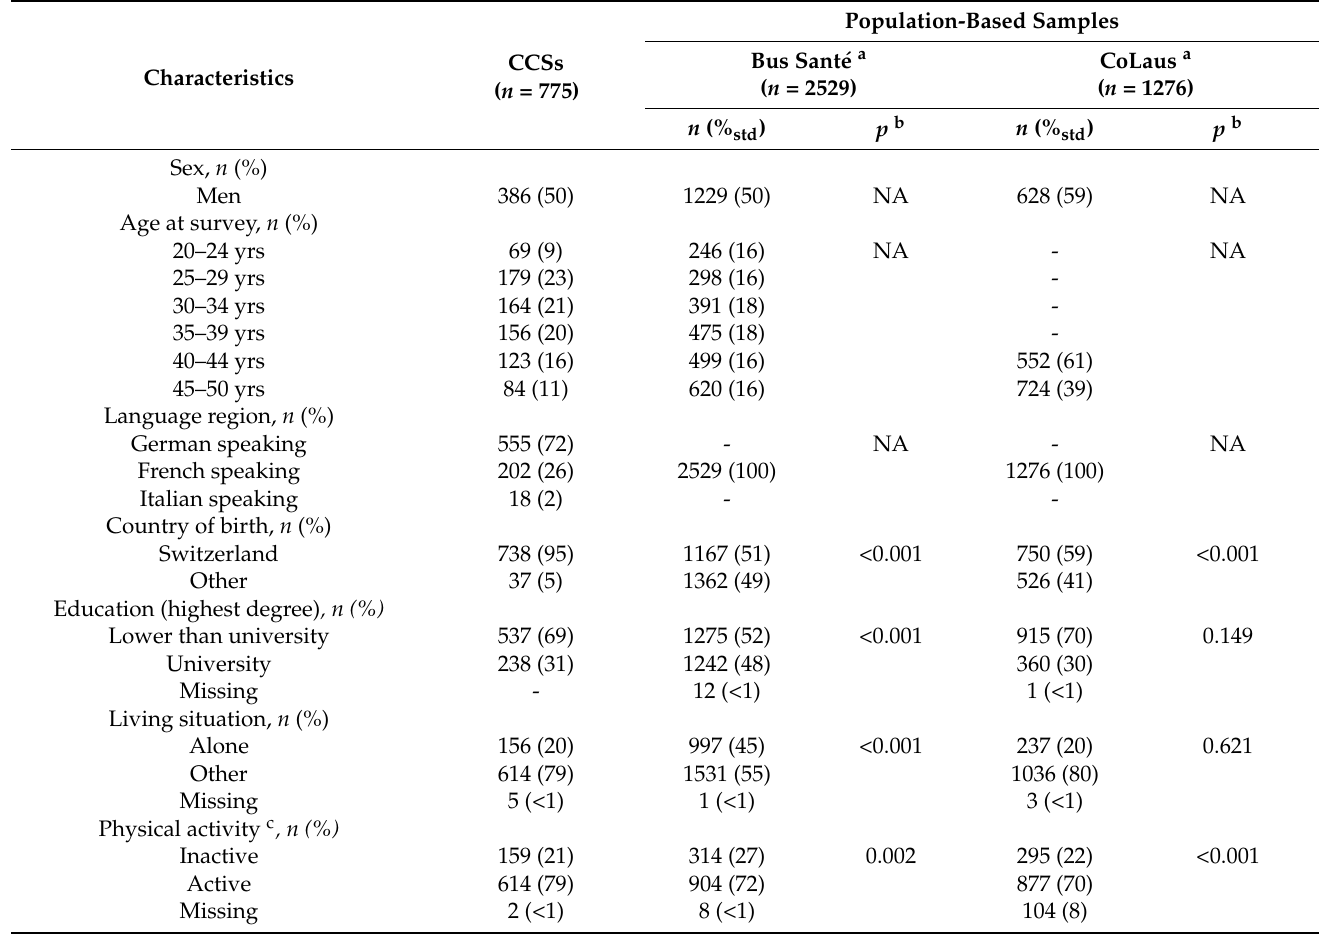
Table 1. Characteristics of childhood cancer survivors and the general population in Switzerland.